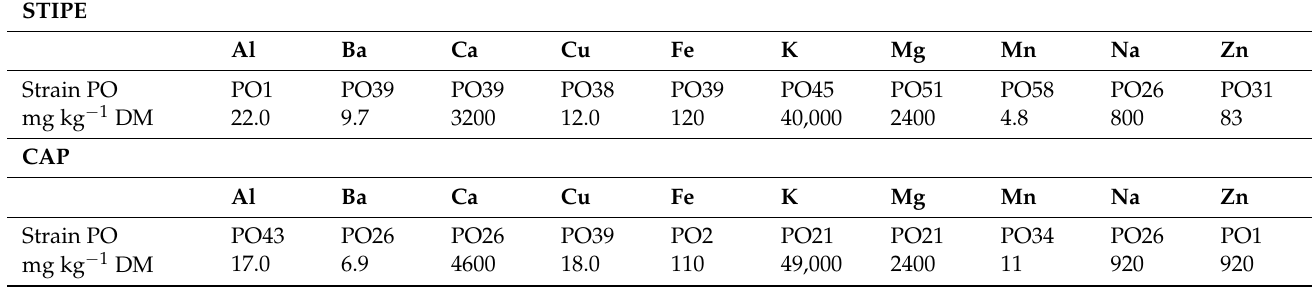
Table 5. Maximum concentrations of metals in the stipes and the caps of the observed oyster mushroom